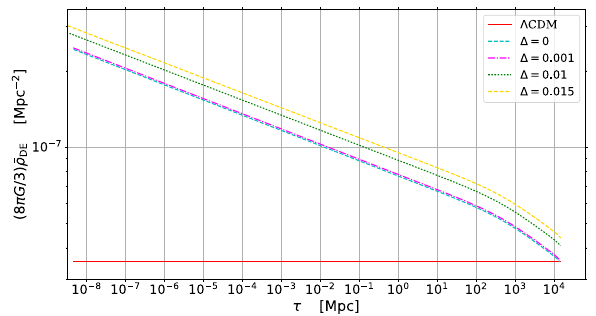
Fig. 4 Theevolutionofdarkenergydensityintermsofconformaltime in Barrow cosmology compared to (cid:3) CDM